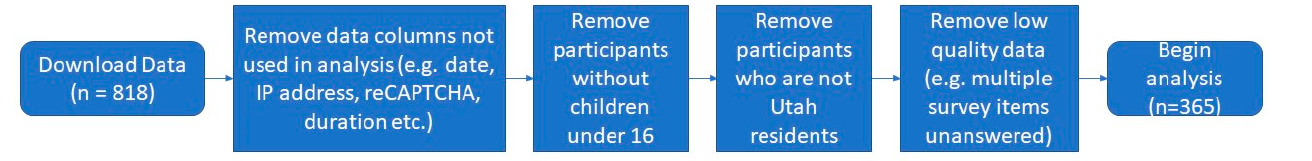
Figure 1. Pre-analysis data cleaning: We downloaded data collected by Qualtrics. Data columns that contained data that would not be used in analysis were removed (e.g., start date, end date, IP address, reCAPTCHA, etc.) Next responses of participants who did not meet our exclusion criteria (Utah resident and have a child 15 or younger) were removed. Low quality data was also removed (e.g., multiple survey items left unanswered, outcome variables left blank) Cleaning reduced our sample size from 818 to